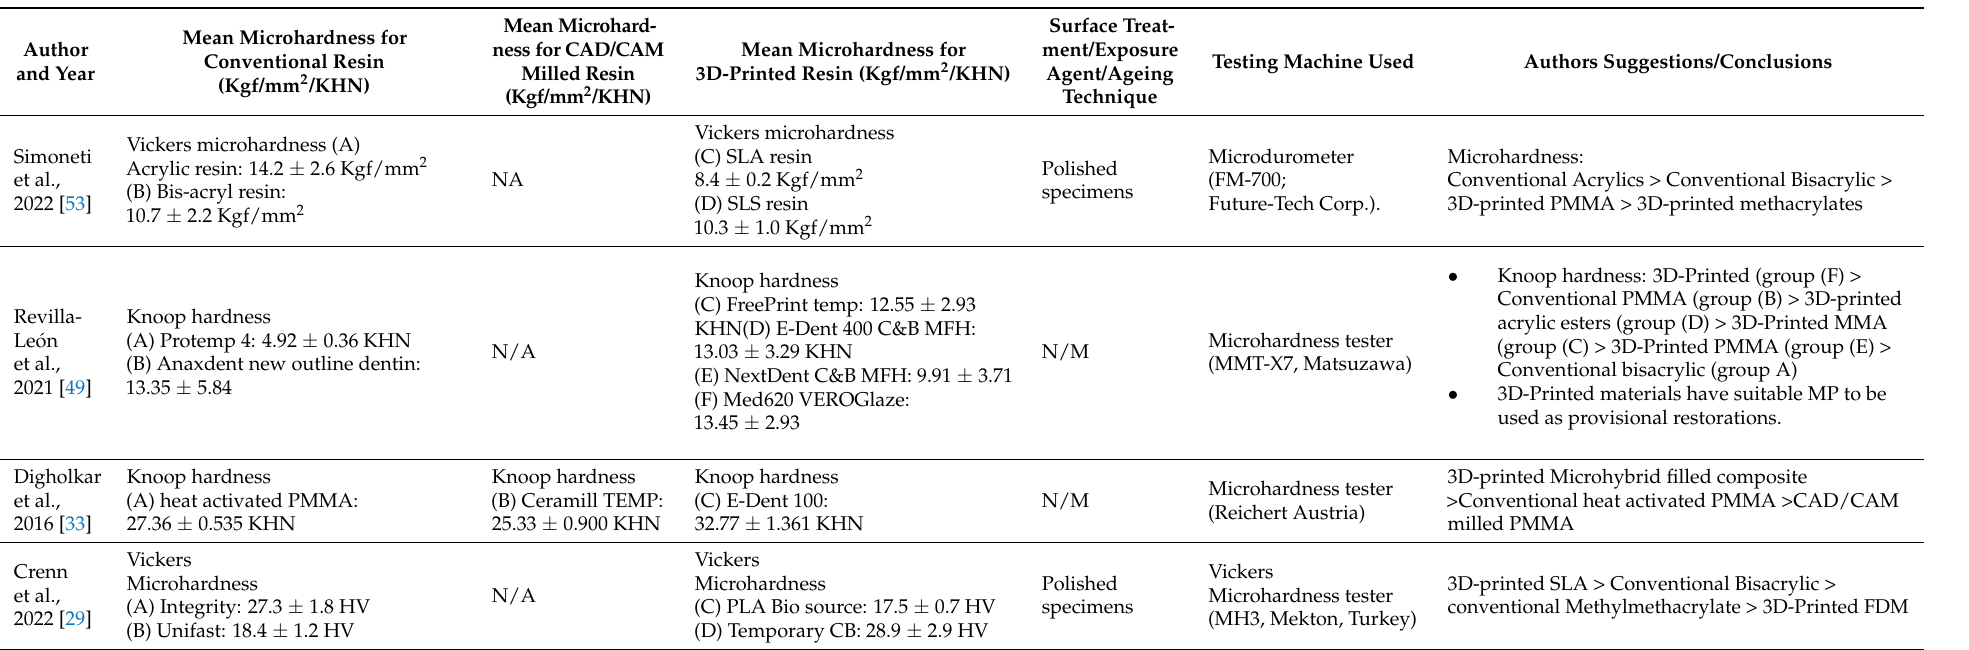
Table 8. Microhardness Test